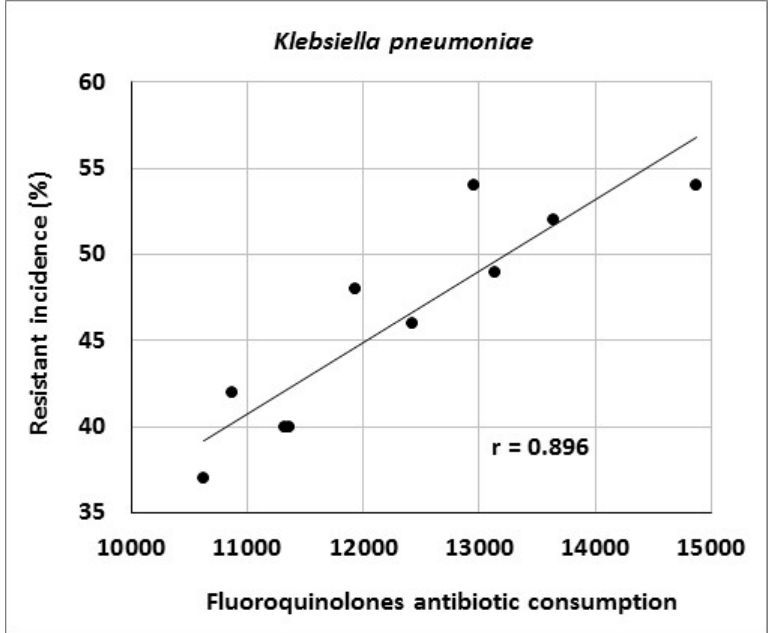
Figure 2. Correlation between fluoroquinolone consumption (in numbers of defined daily doses) and resistance of Klebsiella pneumoniae to ciprofloxacin .